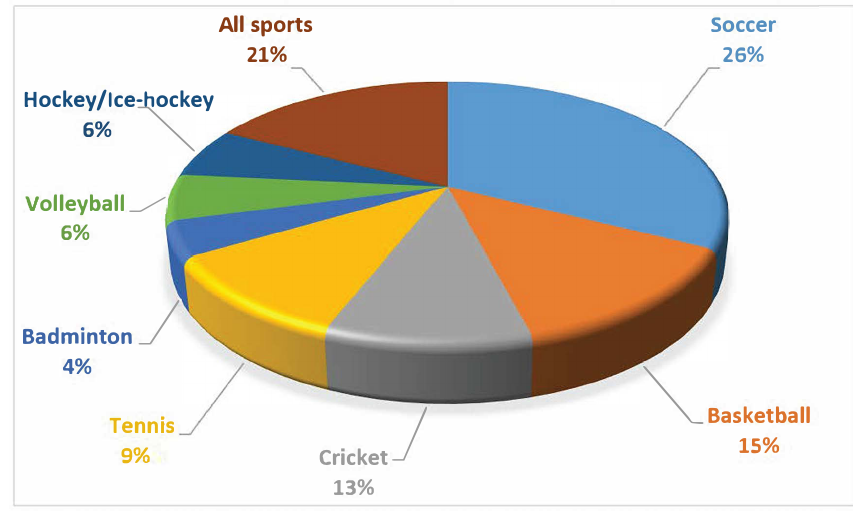
Figure 4. Sports wise research progress.